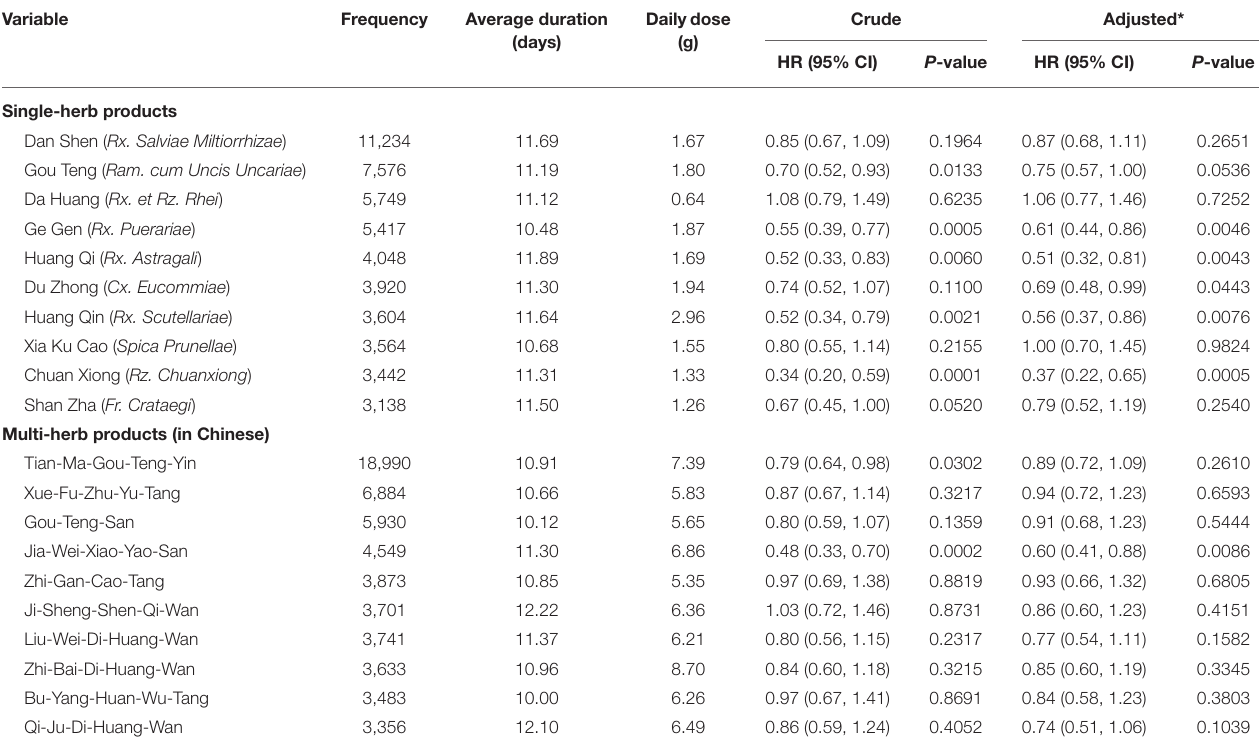
TABLE 5 | Crude and adjusted HRs with 95% CIs of heart failure associated with ten most common used single- and multi-herb CHM drugs in hypertensive patients. Variable Frequency Average duration